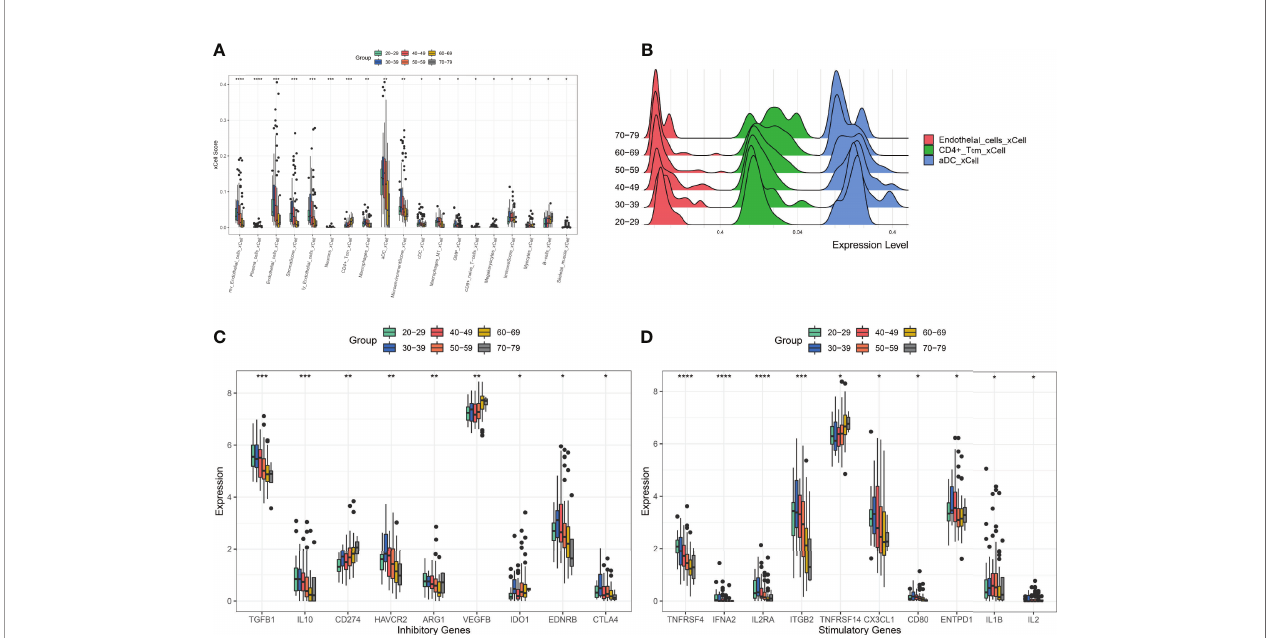
FIGURE 2 | Comparison of XCELL scores of ovarian tissues. (A) Cell types with signi fi cant differences. (B) Distribution of Endotheial cells, CD4+ Tcm, aDC in the six age groups. (C) Comparison of immune-inhibitory checkpoint gene expression. (D) Comparison of gene expression in immune-stimulatory checkpoints. *p < 0.05, **p < 0.01, ***p < 0.005, ****p <